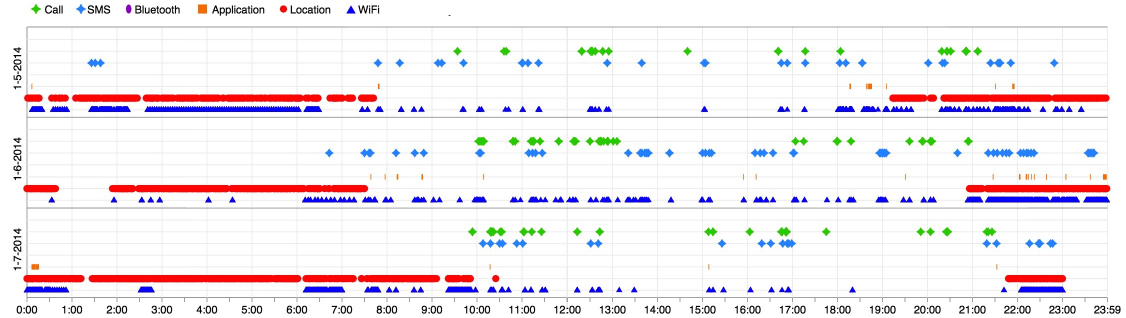
Figure 1. UbiqLog life log visualization of three days of data for a single user (best viewed in